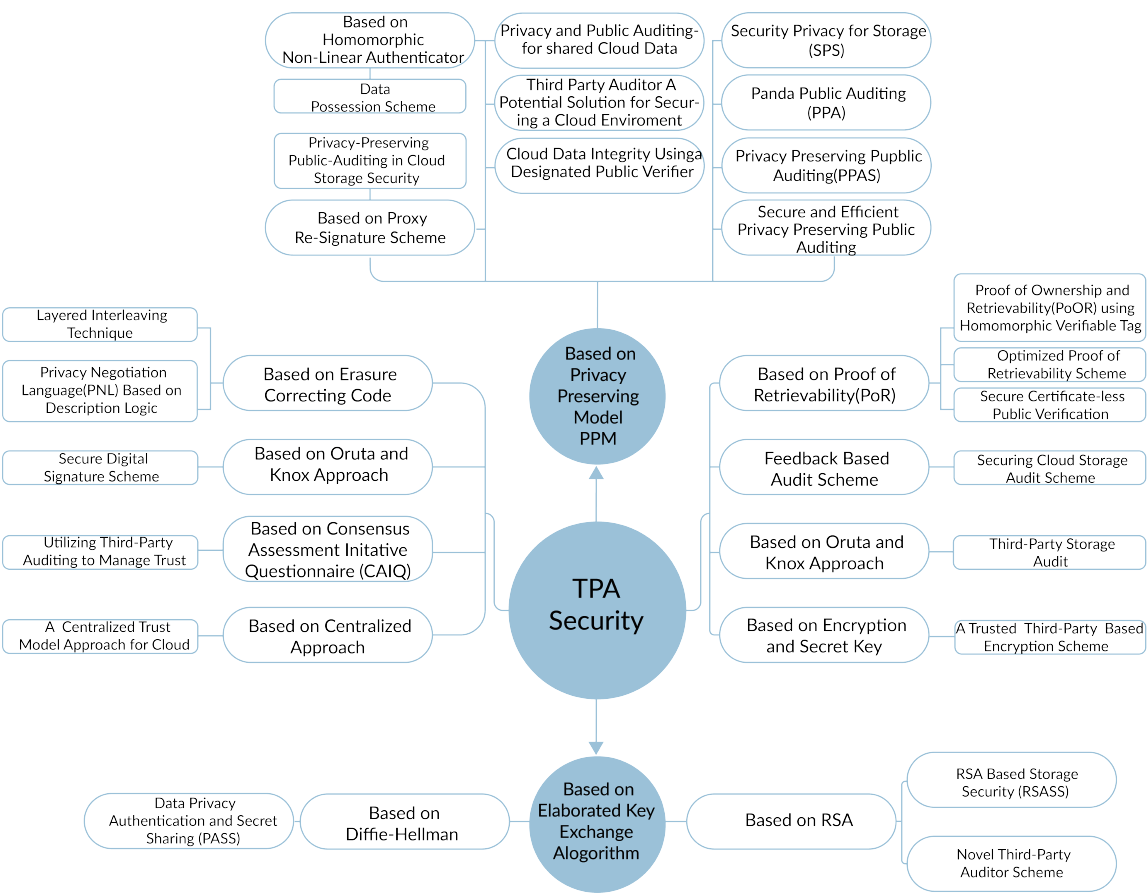
Figure 4. TPA Classification based on the Security